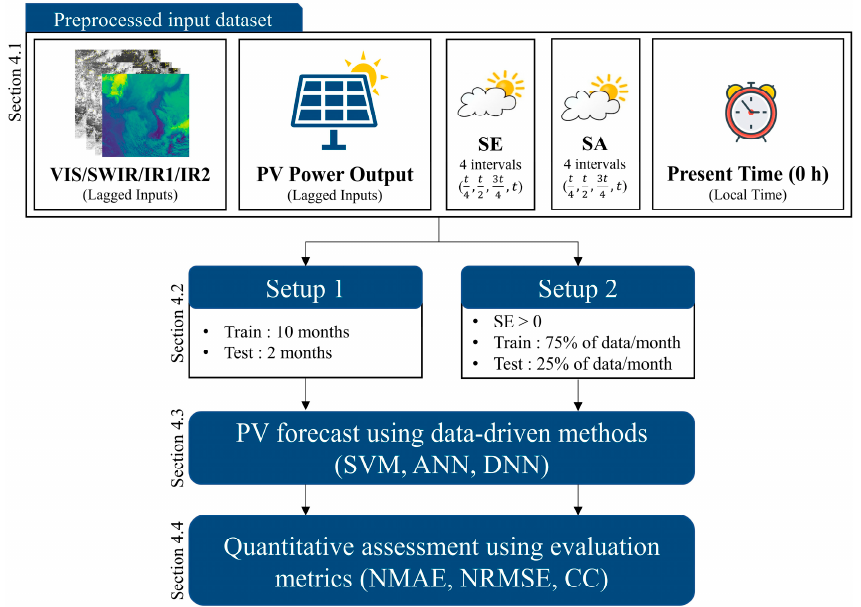
Figure 8. Overview of the main processing steps illustrating the implementation of Sections 4.2–4.4 on the preprocessed input dataset.